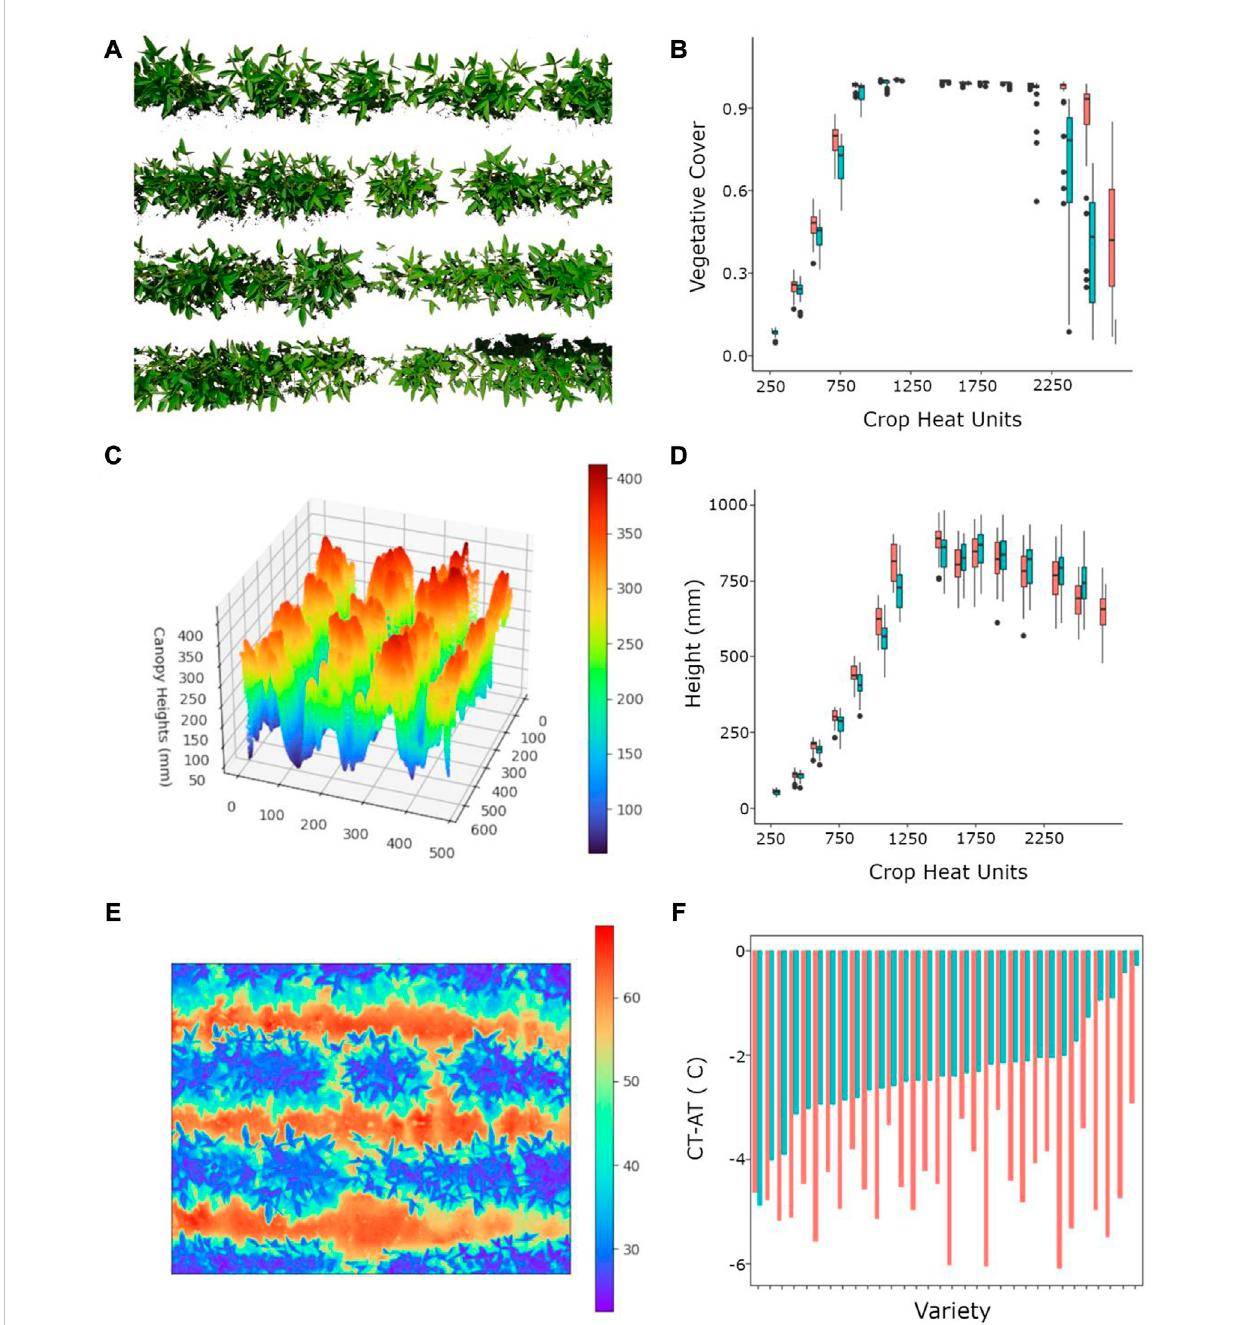
FIGURE 4 ImagedatatypescapturedbythePlotCamandtheircorrespondingoutputdata; (A) segmentedRGBimage(2545 mm×1740 mm), (B) irrigated(red) andnon-irrigated (blue)vegetativecover boxplotsovertimeshowingthemedian,25thand75thpercentiles,andoutliersfrom32soybean cultivars, (C) a colorized canopy surface height pro fi le (1870 mm × 1440 mm, horizontal axes are pixel coordinates), (D) canopy HT over time paired box plots for irrigated and non-irrigated varieties, (E) infrared thermography colour representation of a soybean canopy (colour scale in C o , 1700 mm × 1180 mm), (F) a comparison of average canopy temperature air temperature difference (CT-AT) for irrigated (red) and non-irrigated (blue) soybean varieties sorted from non-irrigated low to high CT-AT